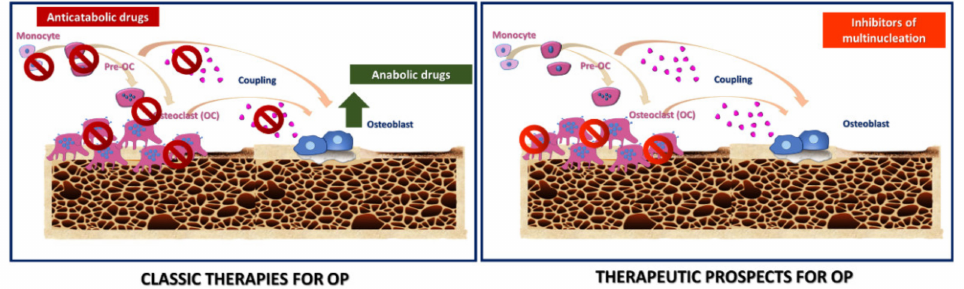
Figure 3. Graphical representation of classic and new therapeutic prospects for OP. The left panel illustrates standard remedies for OP, divided into two classes: anti-catabolic and anabolic drugs. The first class inhibits bone resorption by targeting either the di ff erentiation, resorptive function, cytokines production by osteoclasts (OCs). The second class builds up bone architecture, stimulating osteoblasts (OBs) and their precursors. The right panel outlines new therapeutic prospects for OP. It refers to inhibitors of multinucleation, which would preserve the OCs precursors to support the OCs-OBs